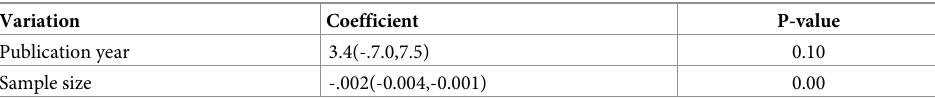
Table 2. Related factors with heterogeneity of birth asphyxia prevalence in this meta-analysis, in Ethiopia,